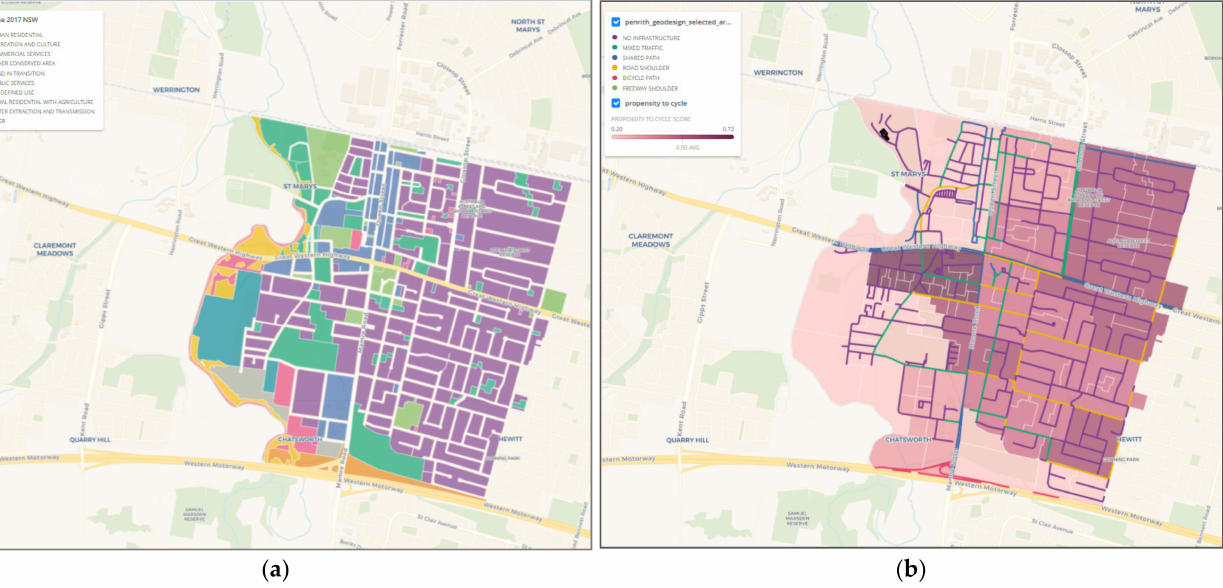
Figure 6. Example of used maps and data: ( a ) land use; ( b ) propensity to